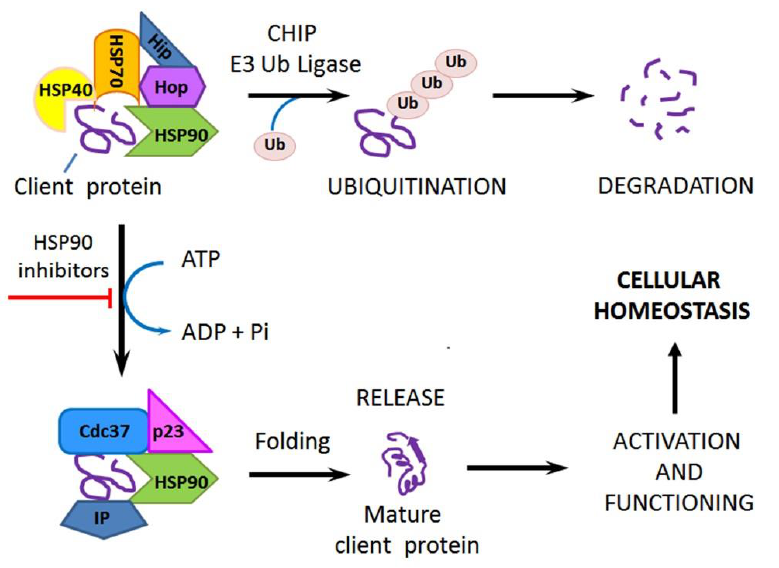
Figure 2. A simplified scheme showing the work of HSP90 chaperone machine. This ATP-dependent chaperoning is carried out by the two major chaperones HSP90 and HSP70 in cooperation with several co-chaperones and co-factors, including HSP40, Hip, Hop, cell division cycle control protein 37 (Cdc37), p23, and immunophilins (IP) (adapted with some modifications from Kabakov et al. [49]). For different client proteins, a set of the assisting co-factors may somewhat vary and include other components [50]. It is seen from the scheme that a client protein may end up in two alternative outcomes of the chaperoning: folding and maturation or ubiquitination and degradation. The latter path can be promoted by inhibitors of HSP90 activity [49 – 51].